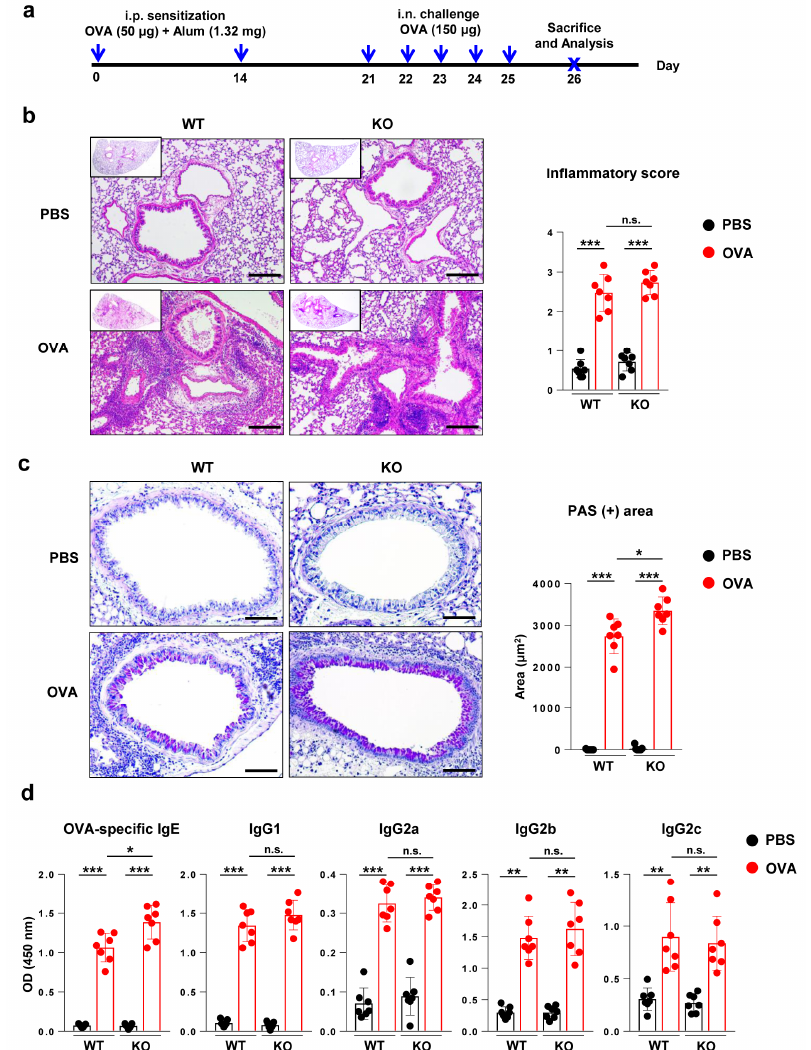
Figure 1 Figure 1. Comparison of disease phenotype between wild-type (WT) and Fms-like tyrosine kinase 3 (Flt3) knockout (KO) mice with ovalbumin (OVA)-induced asthma. ( a ) Experimental scheme and protocol for a mouse model of OVA-induced allergic asthma. Arrows indicate the time points of procedures or sacrifice. i.p., intraperitoneal; i.n., intranasal. ( b ) Representative hematoxylin and eosin-stained sections (original magnification: × 100, magnified image of the × 10 figure in the left upper quadrant) and inflammatory score based on lung histology (scale bar: 100 µ m). ( c ) Representative periodic acid-Schi ff (PAS)-stained section (original magnification: × 200) and PAS-positive areas based on lung histology (scale bar: 50 µ m). ( d ) Serum OVA-specific immunoglobulin (Ig)E, IgG1, IgG2a, IgG2b, and IgG2c were measured using ELISA. Data are representative of four independent experiments with seven mice / group in each experiment. The results are expressed as the mean ± standard deviation. The significance of di ff erences was analyzed using an unpaired Student’s t -test. * p < 0.05, ** p < 0.01, *** p <